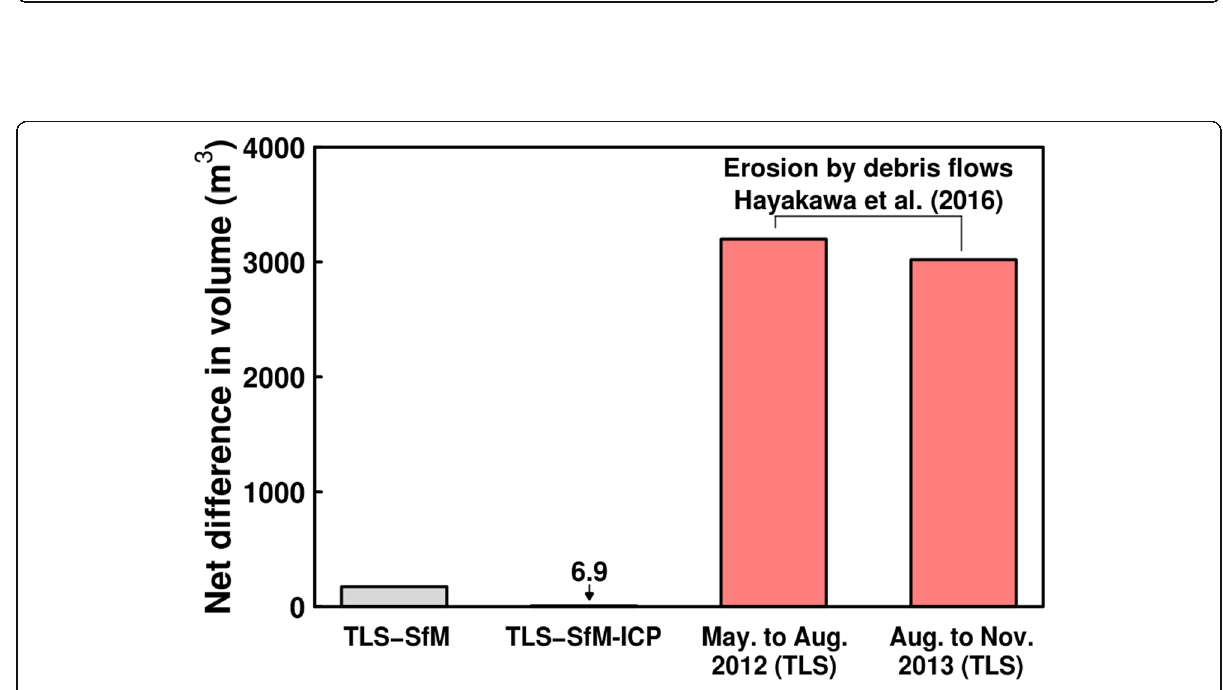
Fig. 6 Difference in net volume in the vicinity of the channel bed. The left two bars indicate the net difference in the volume of DEM SfM or DEM SfM-ICP versus DEM TLS (i.e., the absolute value of the sum of positive and negative volume in Fig. 5). The right two bars indicate the volume of eroded sediment due to debris flows in our study site investigated by Hayakawa et al.